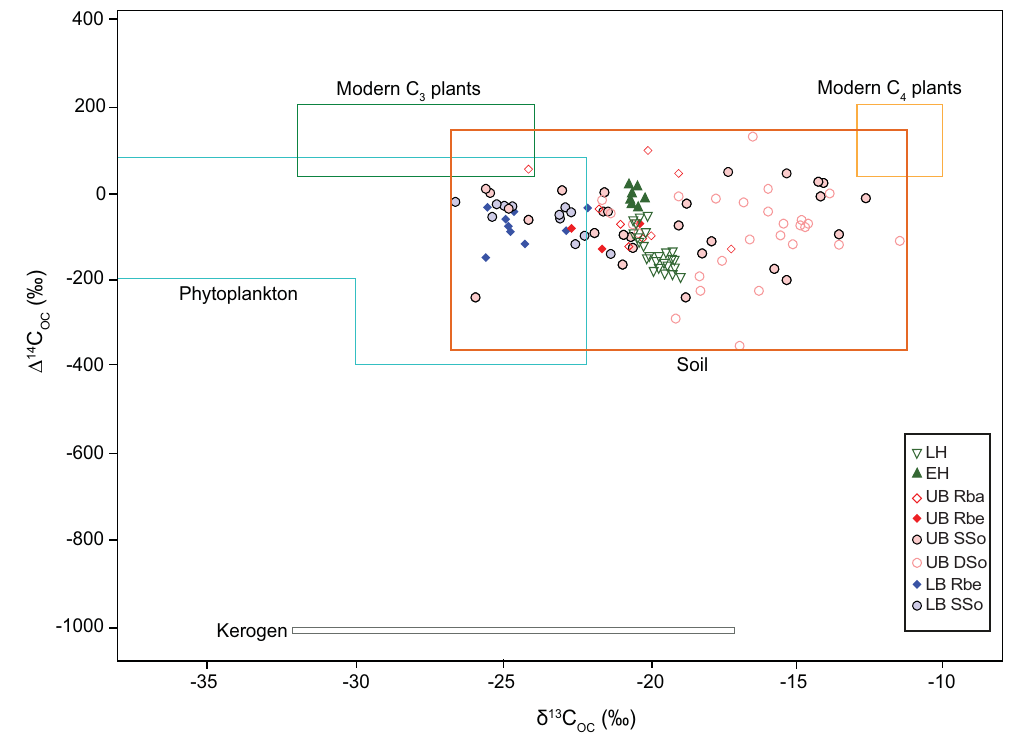
Figure 7. Identifying major sources of organic carbon to the Godavari River and the offshore sediment core using stable ( δ 13 C) and radio ( (cid:49) 14 C) isotopes (Modified after Marwick et al., 2015). The soil end-member is defined based on ranges of values observed within the Godavari and other tropical river systems (e.g. Pessenda et al., 1997; Shen et al., 2001; Trumbore et al., 1989). Symbol key and abbreviations are as for Figs. 1 to